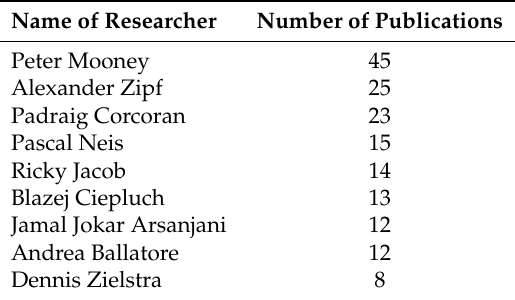
Figure 1. Publications by year during the period 2007–2016. Table 3. Top researchers in OSM